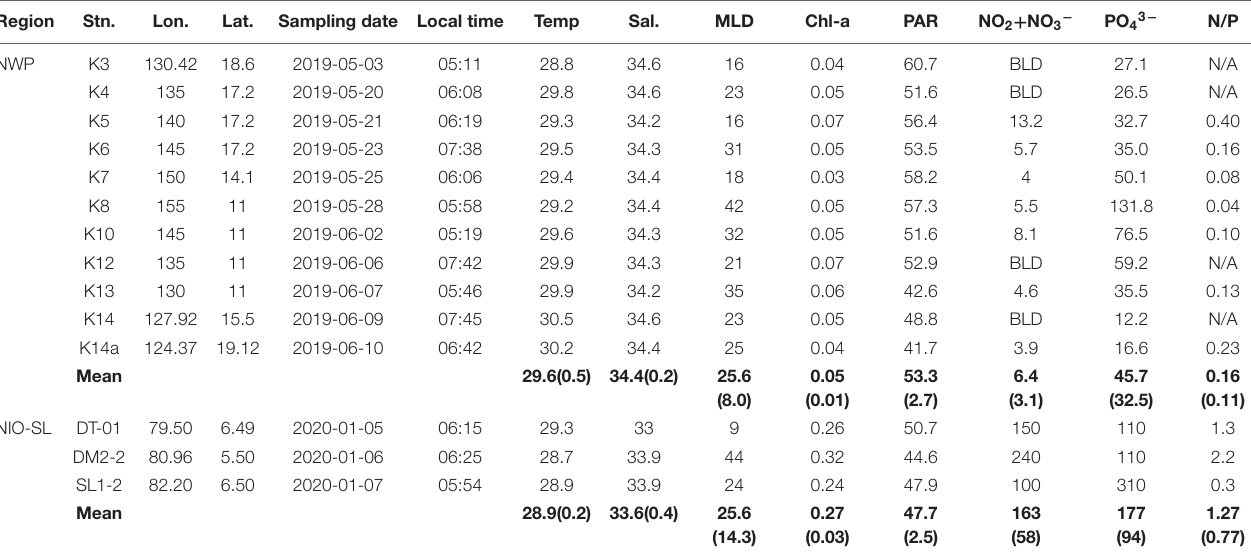
TABLE 1 | Surface values of temperature (Temp, ◦ C), salinity (Sal), mixed layer depth (MLD, m), Chl-a concentration (Chl-a, µ g L − 1 ), PAR (mol photon m − 2 d − 1 ), nitrite and nitrate (NO 2 − + NO 3 − , nmol L − 1 ) and phosphate (PO 43 − , nmol L − 1 ) in the NWP and NIO-SL. Region Stn.